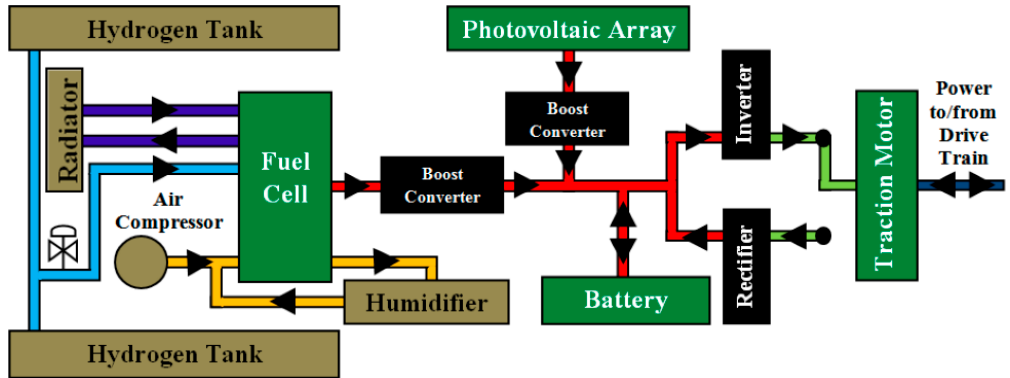
Figure 2. Schematic diagram of the UD fuel cell bus’s PV/PEM fuel cell/NiCd battery hybrid power train. Color legends: (1) Blocks : green, primary components; beige, auxiliary fuel cell components; black, power conditioning units; and (2) Streams : purple, glycol/water mixture; light blue, hydrogen; yellow, air; red, DC power; light green, AC power; dark blue, mechanical power to/from the drive train. Black arrows indicate stream flow